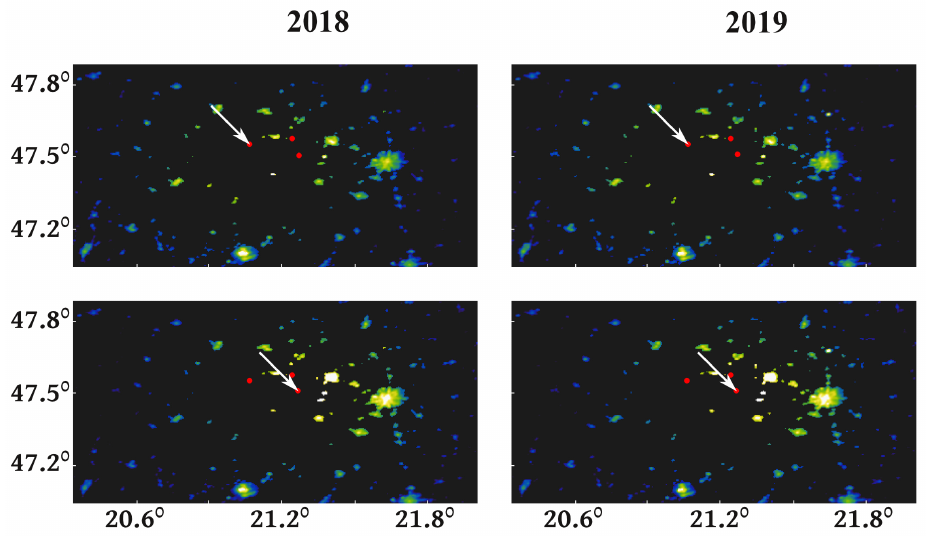
Figure 12. Weighted source map based on the VIIRS images from 2018 and 2019 for two different observation points (indicated by